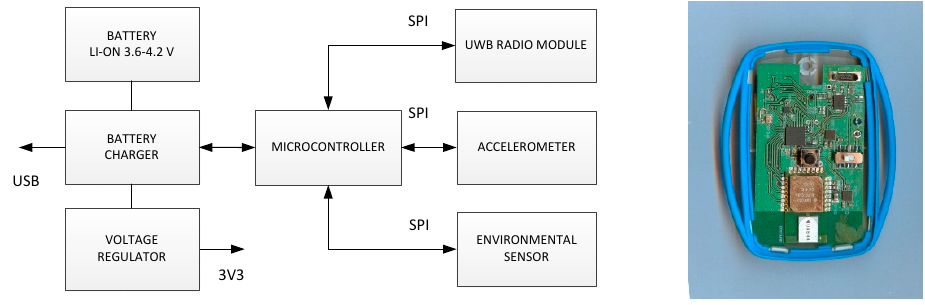
Figure 3. Tag architecture and assembled tag.